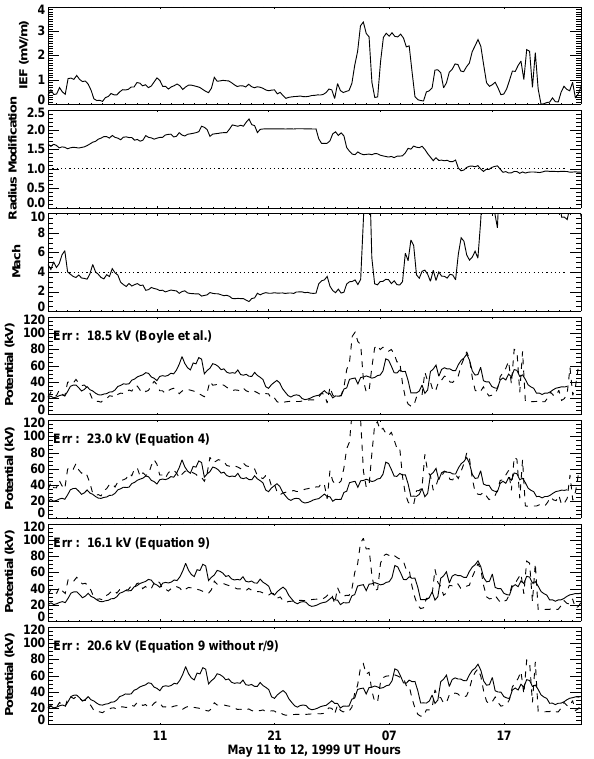
the error when only the Mach number is considered,